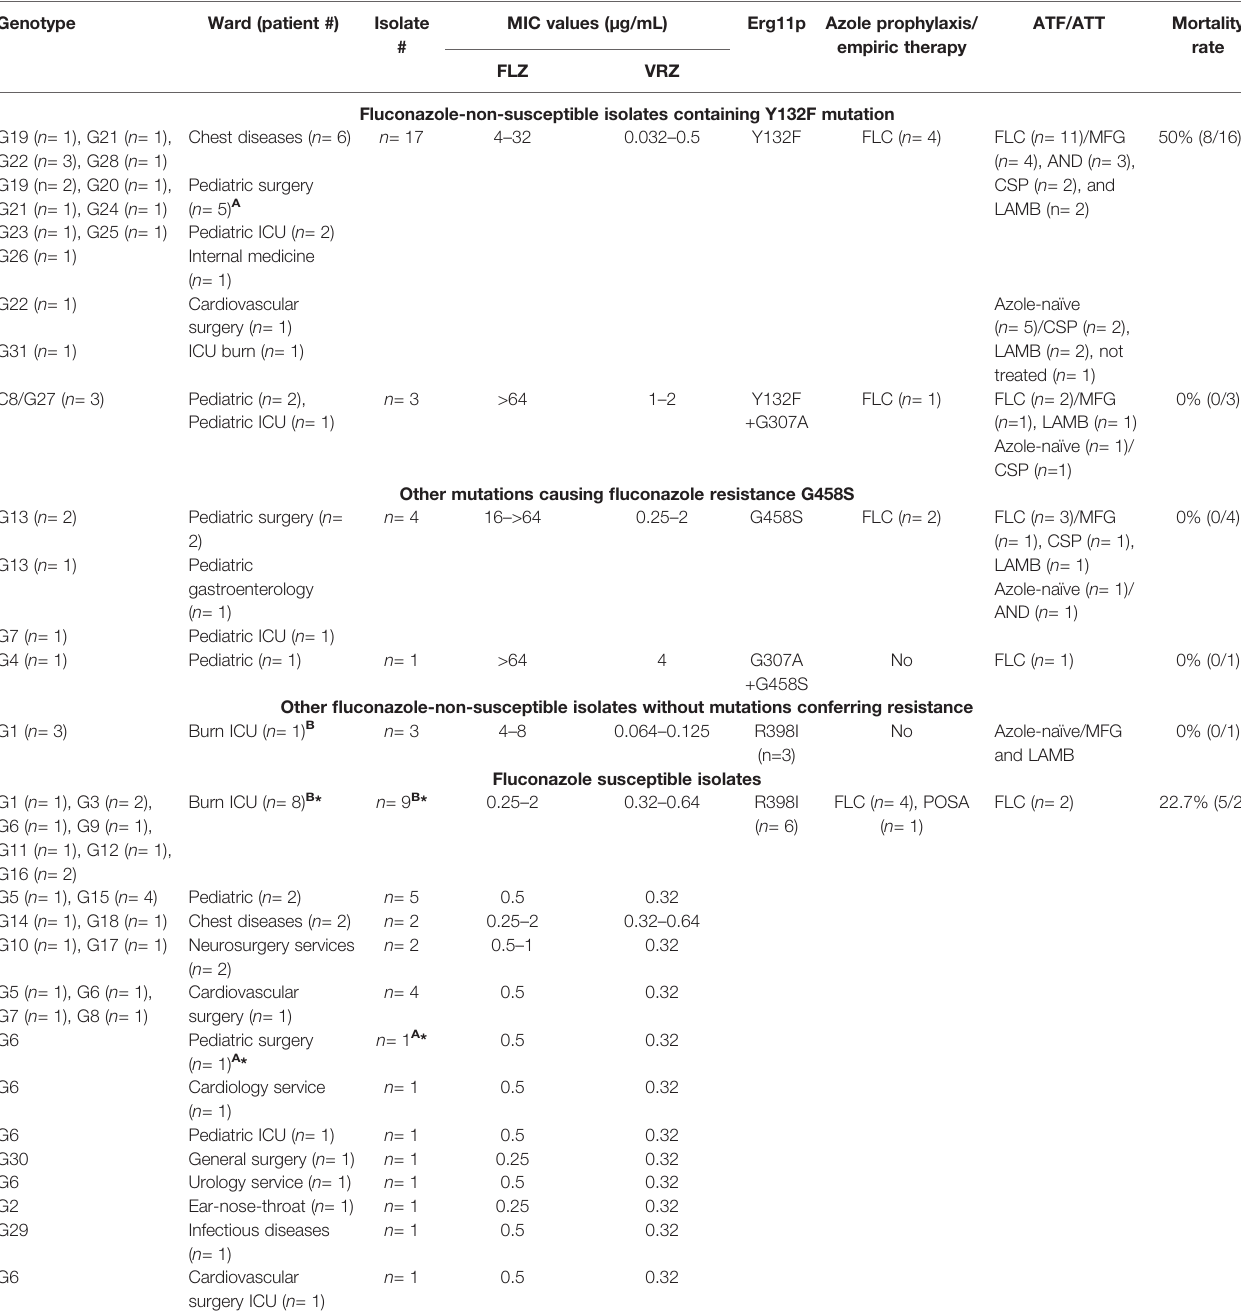
TABLE 1 | Comprehensive microbiological and clinical data of candidemic patients infected with C . parapsilosis in Ege University Hospital between 2019 to 2020.